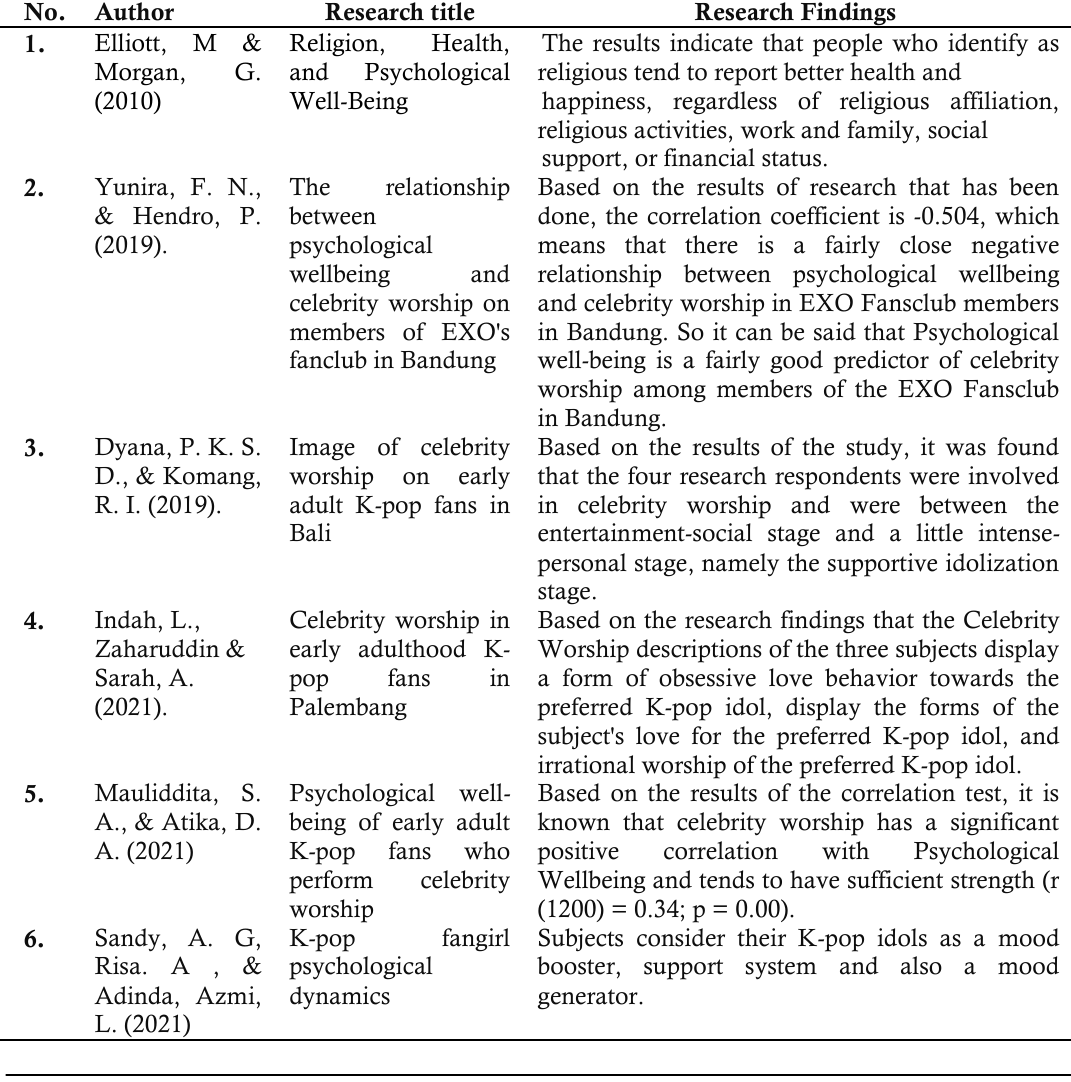
Table 1 <Summary of Literature